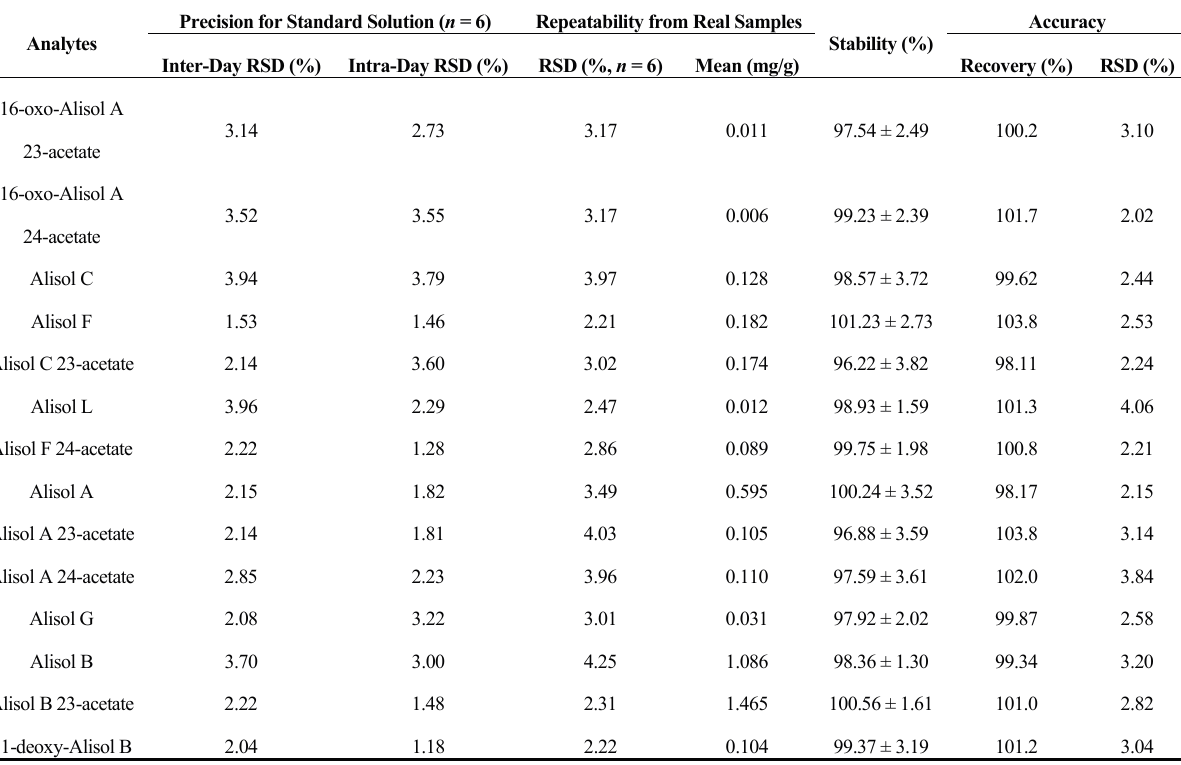
Table 4. Precision, repeatability, stability, and recovery of fourteen analytes ( n =